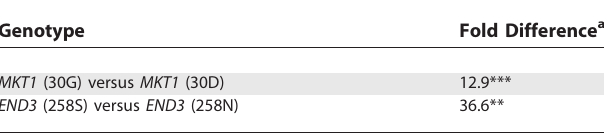
Table 4. Growth Difference at 41 8 C between YJM145/S288c Hybrids Containing YJM145- versus S288c-Derived RHO2 3 9 UTRs Genotype